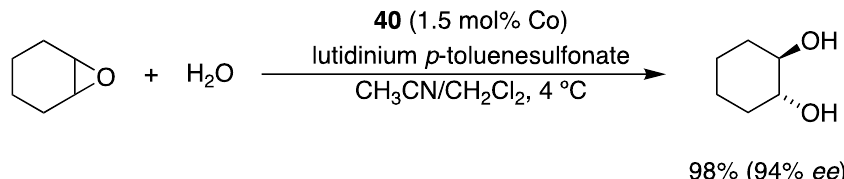
Figure 18. Macrocyclic oligosalen mixtures 40 and 35 and monomeric analogue 41 .